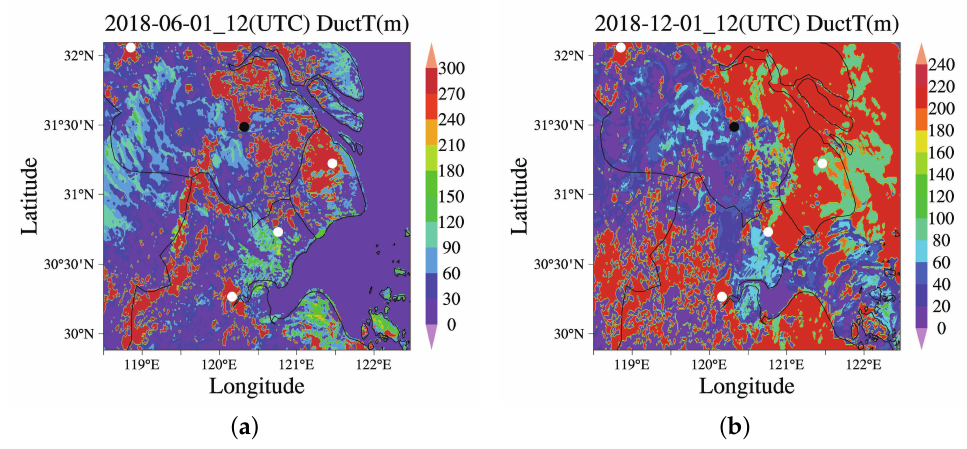
Figure 4. Duct height (m) calculated by WRF on 1 June and 1 December 2018. ( a ) Duct height (m) on 1 June 2018. ( b ) Duct height (m) on 1 December 2018.